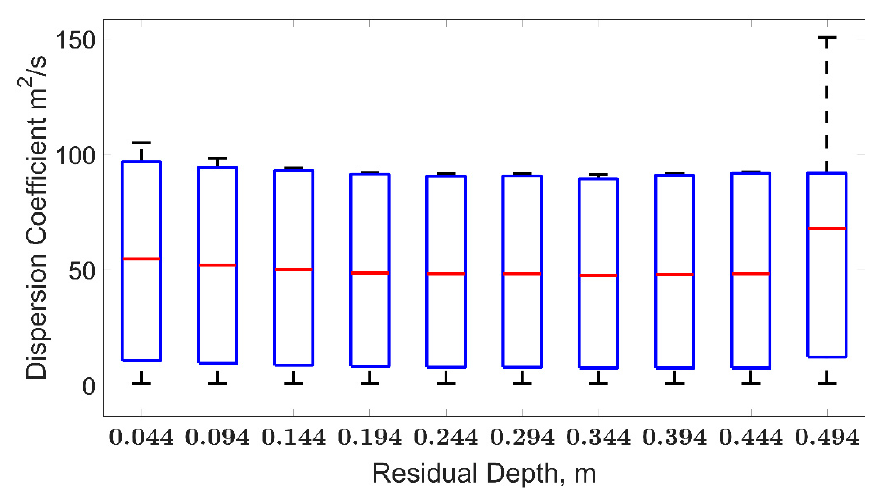
Figure 9. Variation of dispersion coefficient values calculated in the numerical pool-riffle sequence through the empirical equations of Table 1, for each